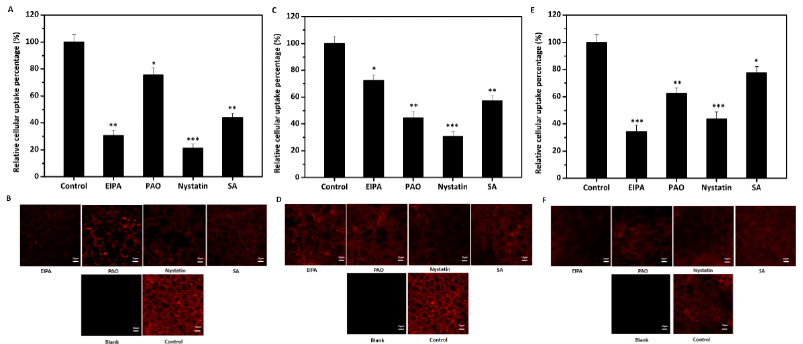
Figure 7. The effects of varying endocytosis inhibitors on the uptake of three lipid-based emulsions (170 nm, 265 nm, and 556 nm, respectively). ( A , C , E ) Relative uptake of emulsions by cells incubated with DMEM without serum and treated with three specific endocytosis inhibitors and also sodium azide (SA). The control without inhibitors was set as 100%. All data were compared to the control using ANOVA (* p < 0.05, ** p < 0.01, *** p < 0.005). ( B , D , F ) CLSM of Caco-2 cells grown on glass treated with inhibitors and exposure to three lipid-based emulsions for 4 h. Scale bar indicates 15 µ m. The data were expressed as mean ± standard with three independent